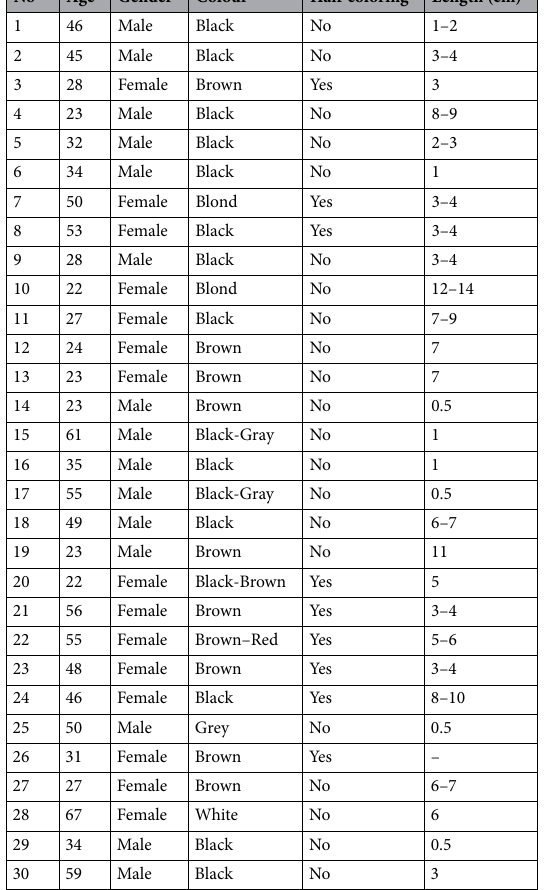
Table 3. Characterization of volunteers taking part in the